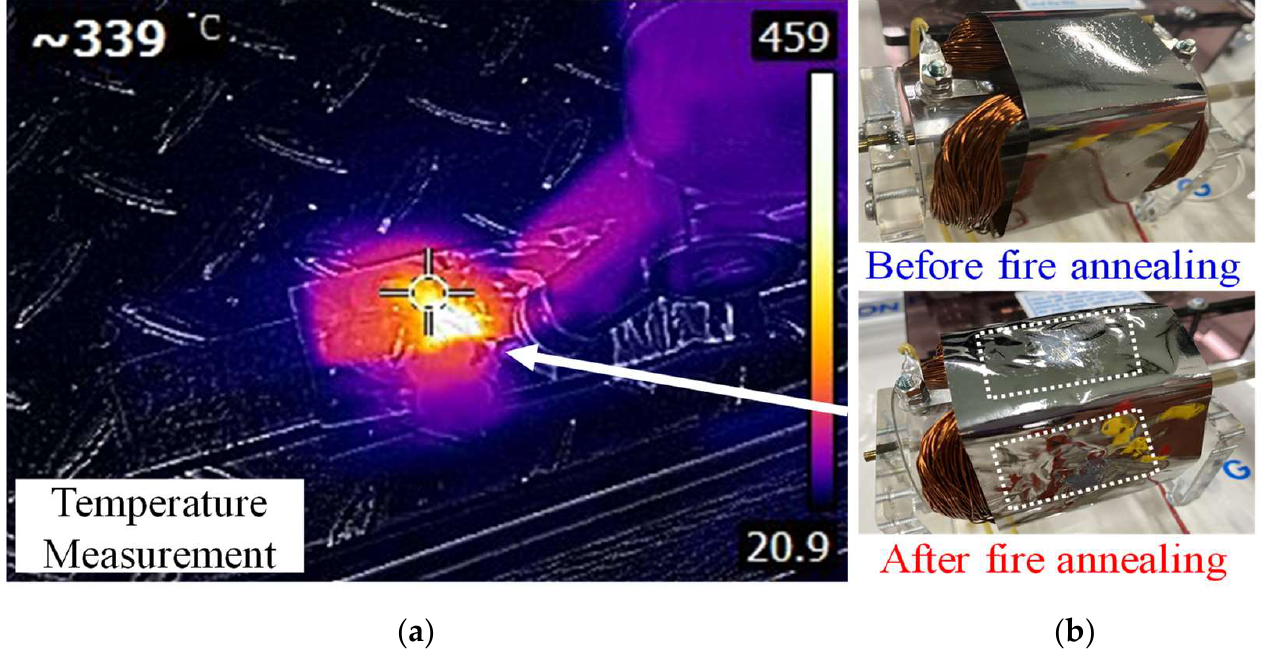
Figure 10. Experimental amorphous-material flame-annealing method used in the shell manufacturing process: ( a ) local annealing process; ( b ) differences in amorphous shell structure.